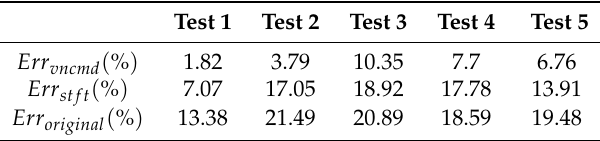
Table 8. Comparisons on estimated heart rates with and without optimizations in initial frequencies of